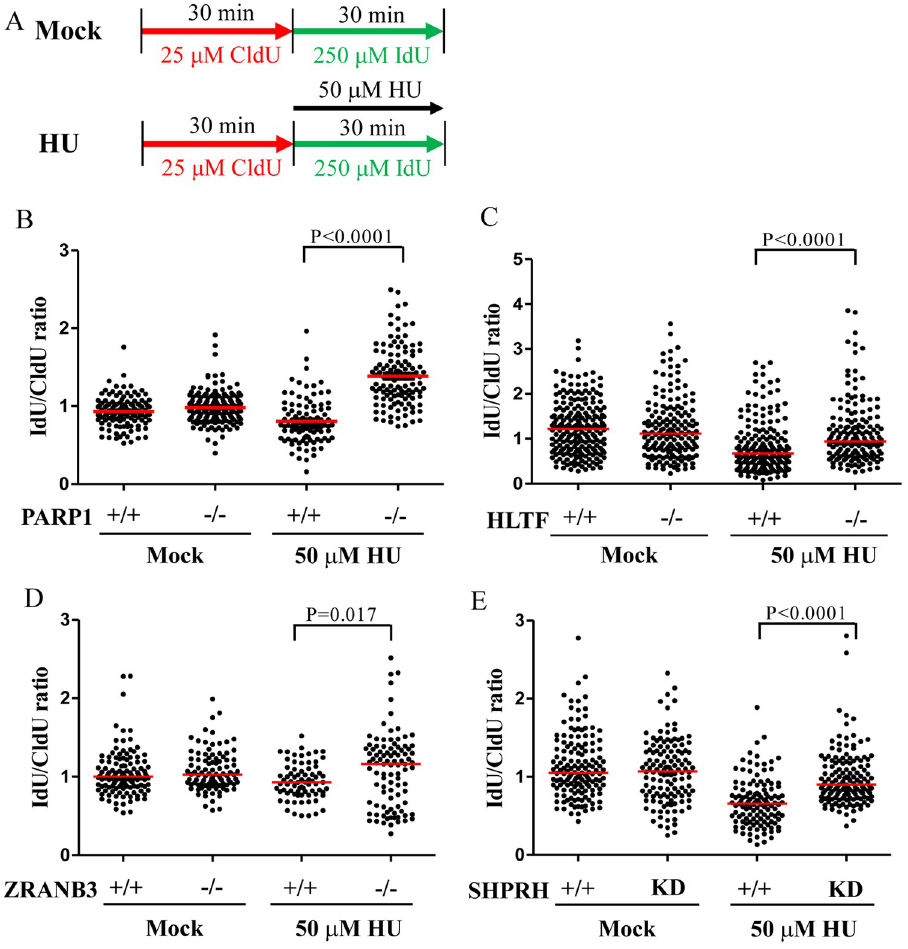
Fig 5. PARP1 and DNA translocases restrain DNA replication upon HU-induced replication stress. (A) Labeling protocols for DNA fiber analysis. (B) - (E) Quantitation of IdU/CldU track length ratios derived from each cell line. At least 100 DNA fibers derived from each cell line were measured. (Raw DNA fiber data in S5